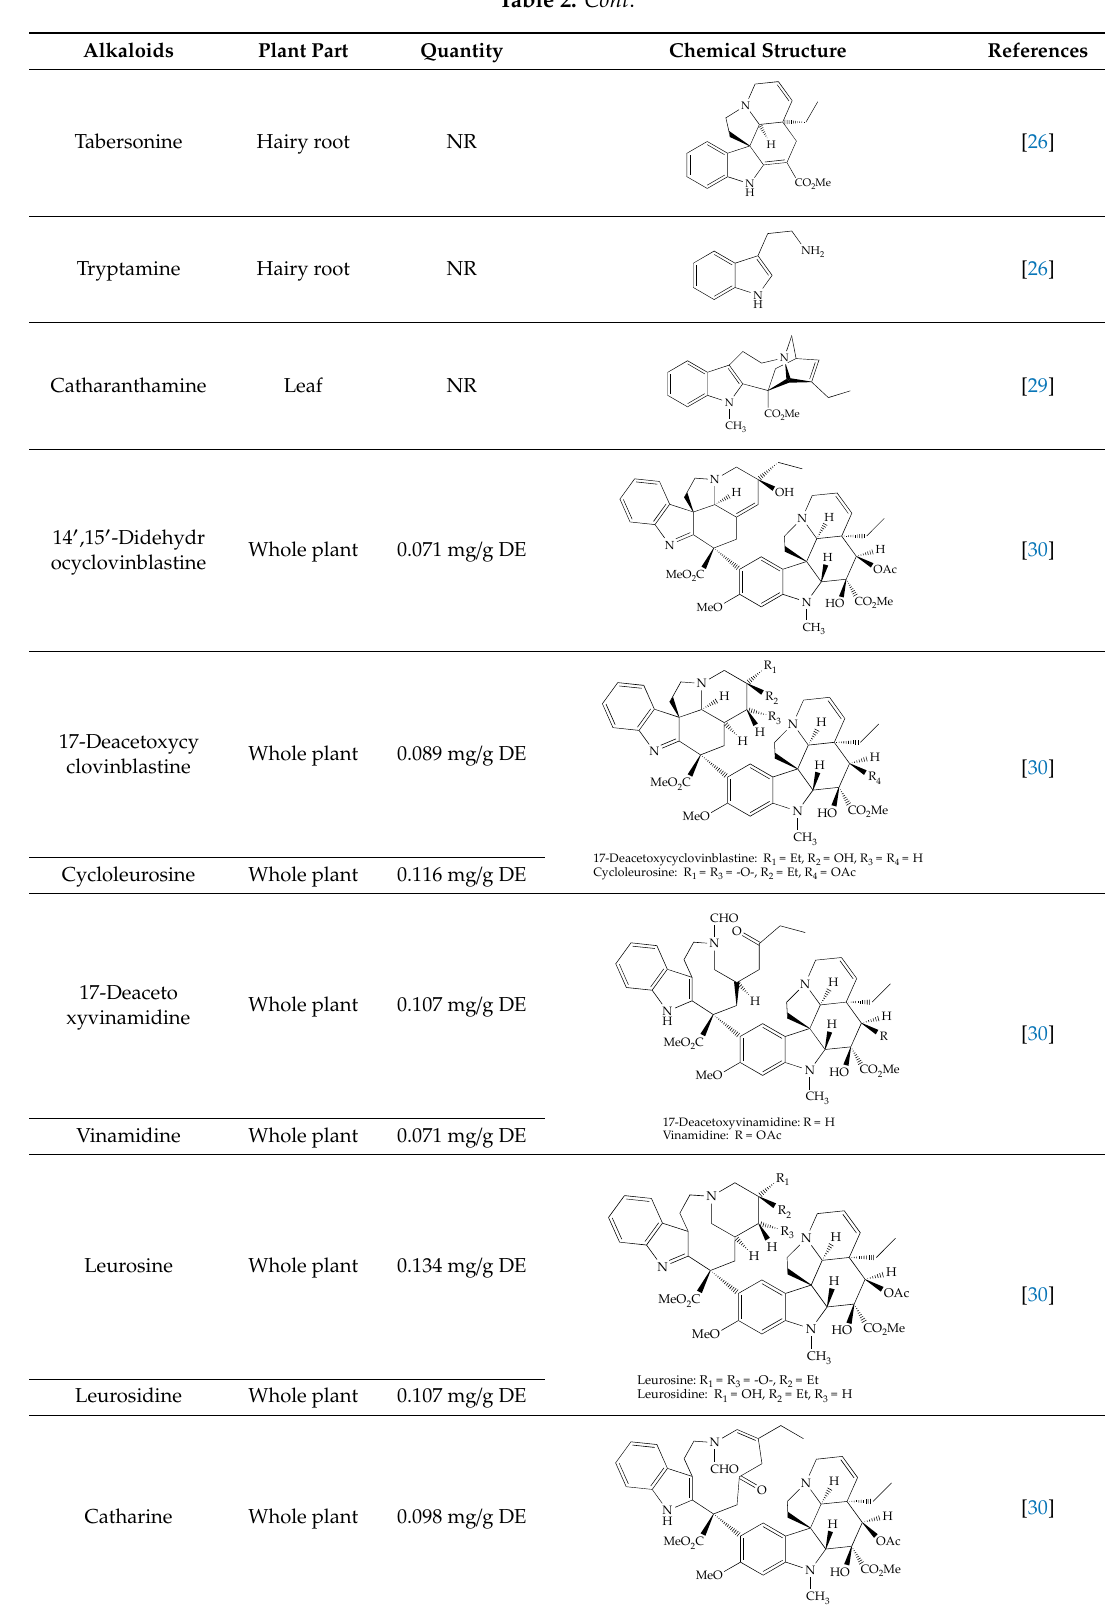
Leurosine: R 1 = R 3 = -O-, R 2 = Et Leurosidine: R 1 = OH, R 2 = Et, R 3 =